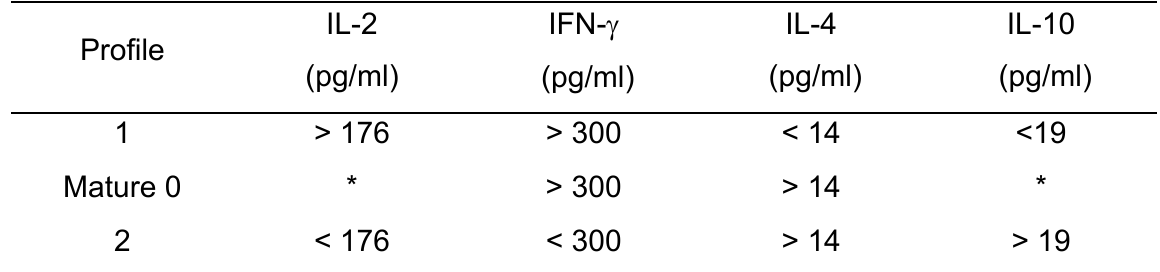
Table 2: Serum cytokine profiles according to subtypes by Spellberg & Edwards-Jr.